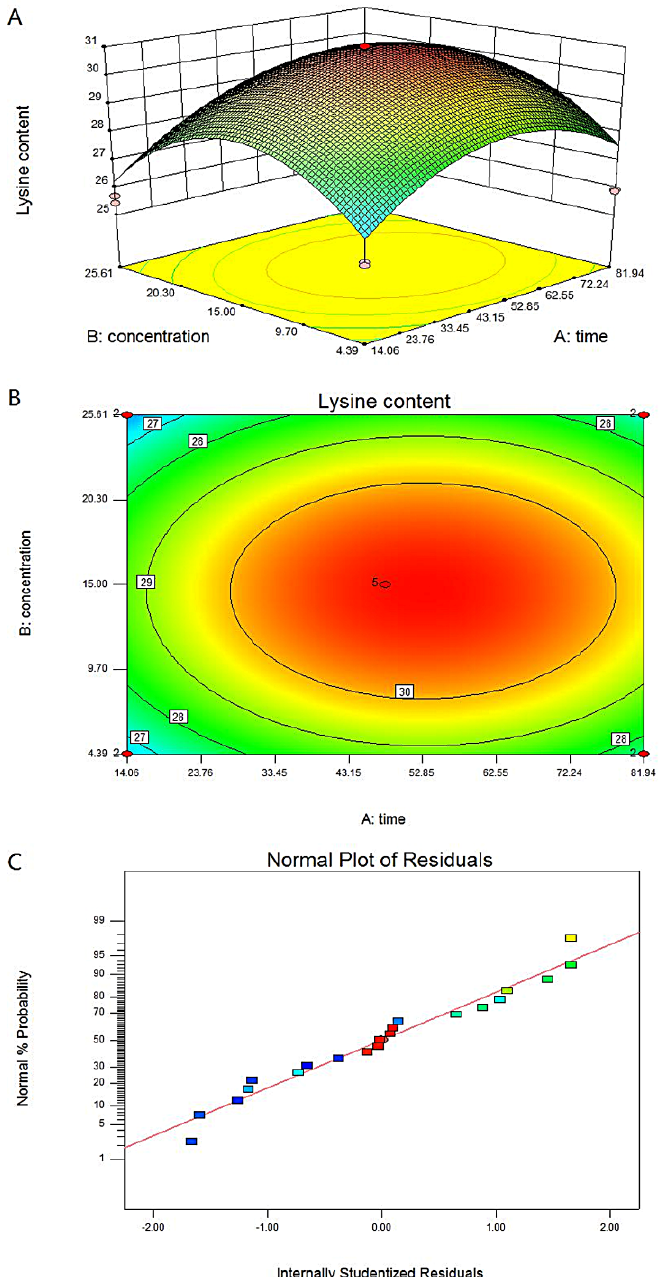
Figure 3. Optimization of lysine accumulation conditions induced by chitosan in F. filiformis . ( A ) A five-level two-factor center combination design is used to maximize the lysine content of F. filiformis . The independent variables are chitosan treatment concentration and treatment time. Table 1 shows the range and level of the independent variables. The levels of the variables are determined based on single factor analysis. ( B ) Contour plots reflect the combined effects of concentration and treatment time on lysine content in F. filiformis . ( C ) Normal probability plot of standardized residuals. Each color block is a response